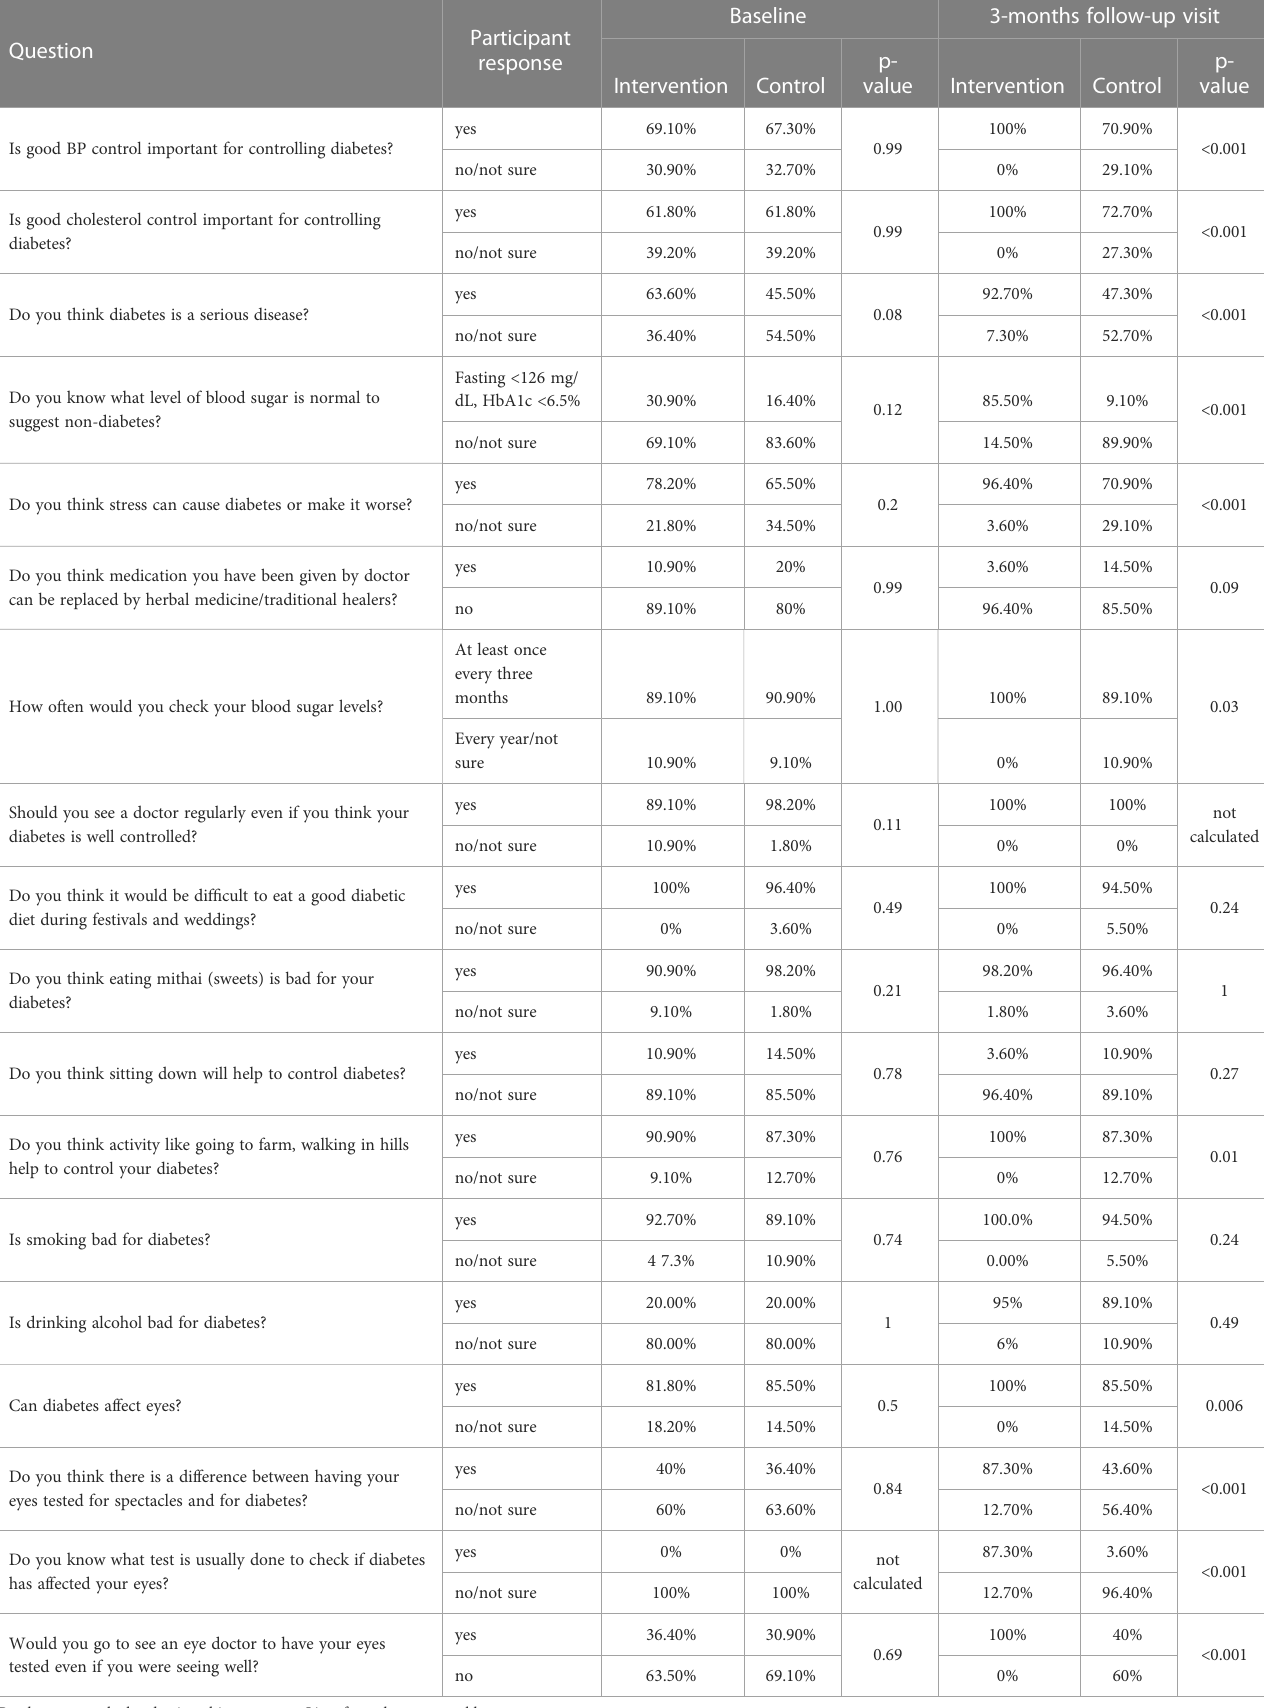
TABLE 3 Percentage of participants in each response category of the questionnaire data at baseline and 3-month follow-up visit for participants in the intervention and the control group.